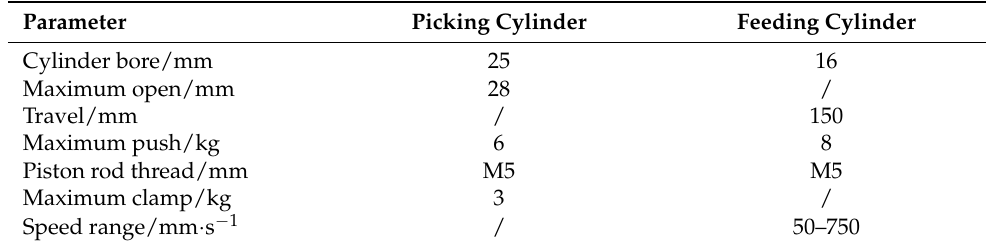
Table 1. Function Table 1. Function parameters. Table 1. Function parameters.